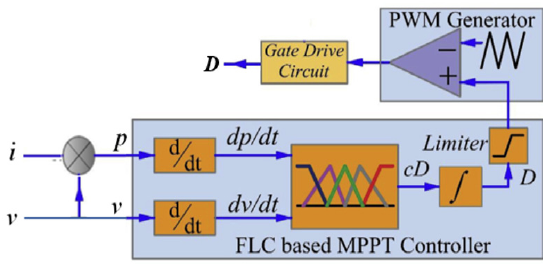
Figure 5. FLC-based MPPT for boost converter.